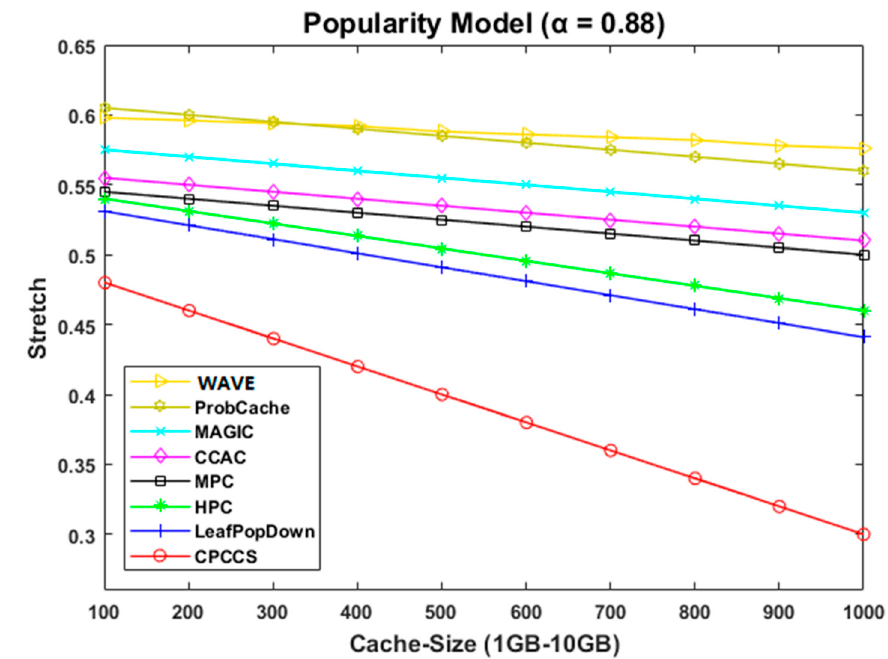
Figure 6. Stretch with UGC.